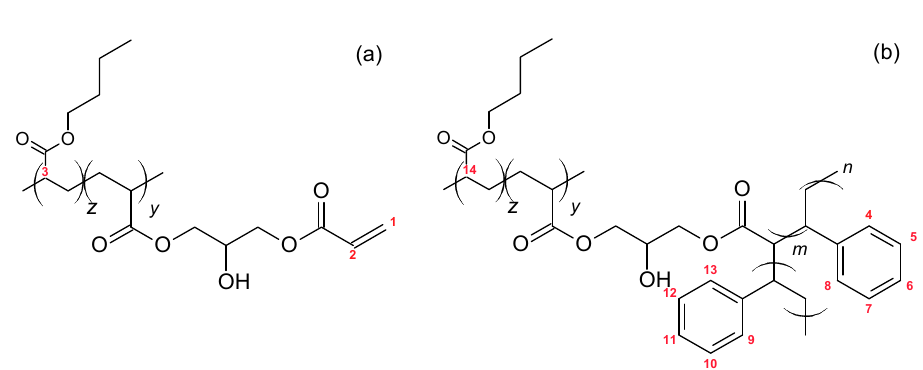
Figure 3. Structure of post-modified backbone ( a ) and graft copolymer ( b ).